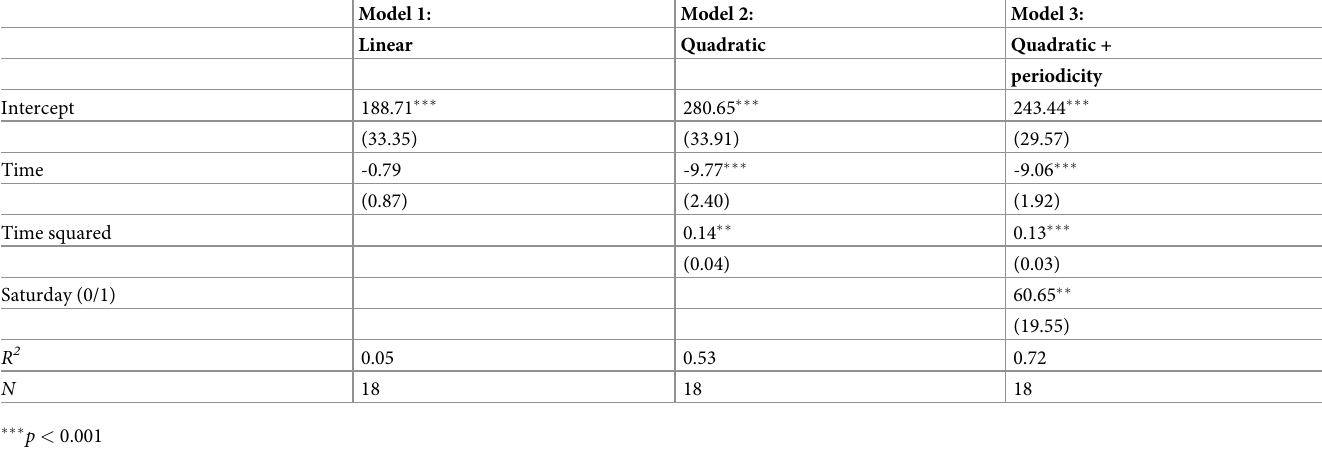
Table 1. Number of social distancing violations regressed on linear time, quadratic time, and